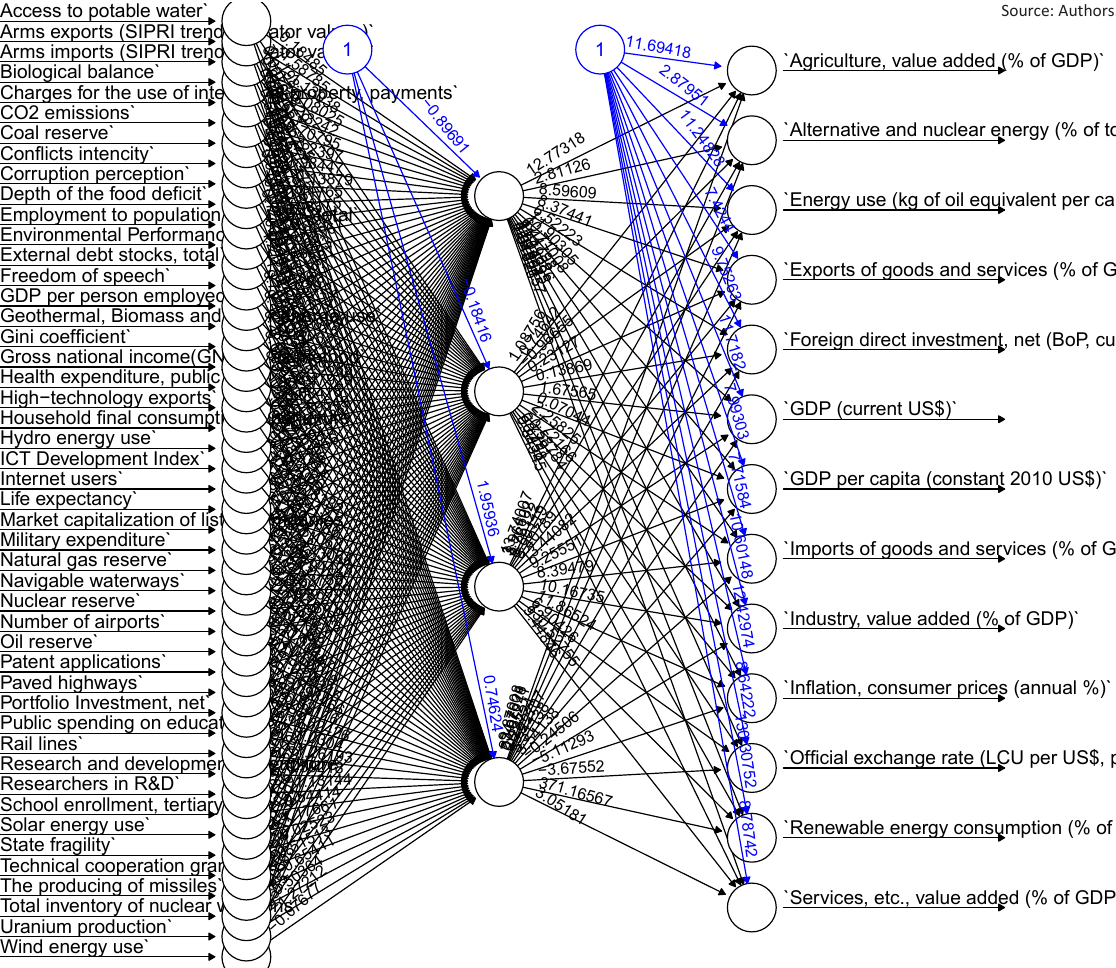
Figure 1. Diagram of an obtained neural